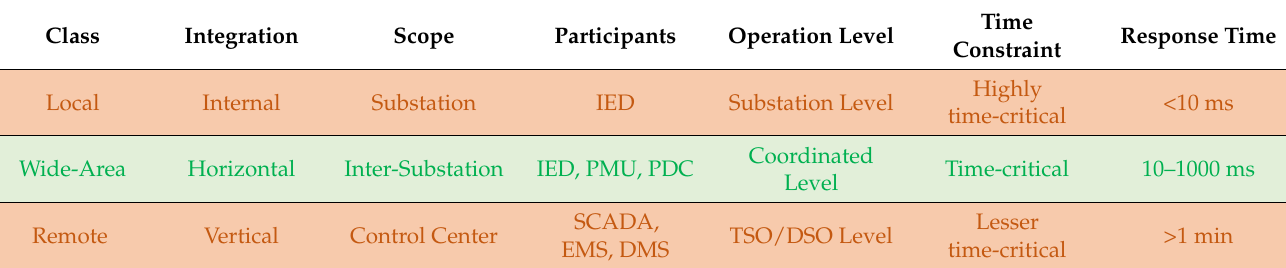
Table 2. Monitoring, protection, and control classes in power